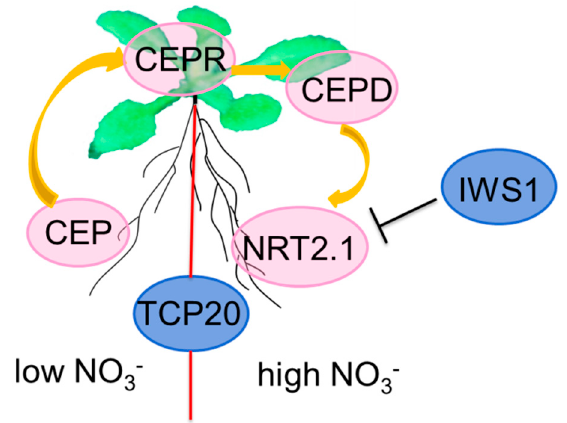
Figure 3. Key genes involved in the systemic signaling pathway that direct nitrate foraging and lateral root growth under heterogeneous conditions. Arrows indicate positive regulation. Blunted lines indicate negative regulation.